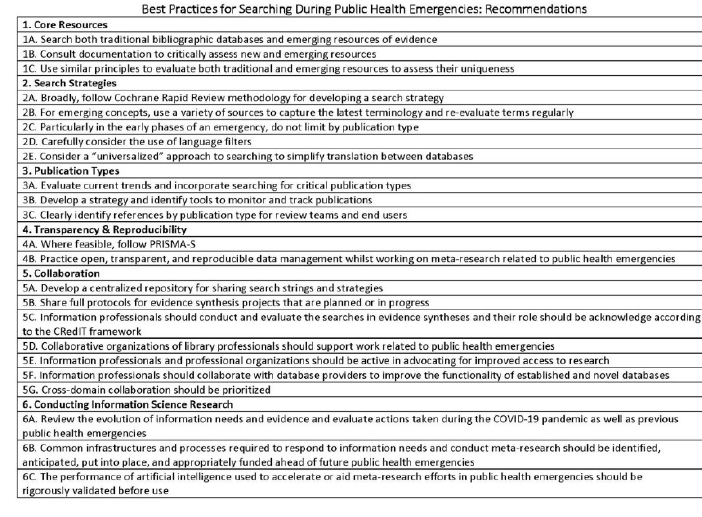
Table 1 The best practices for searching for evidence during public health emergencies include 23 recommendations across 6 core